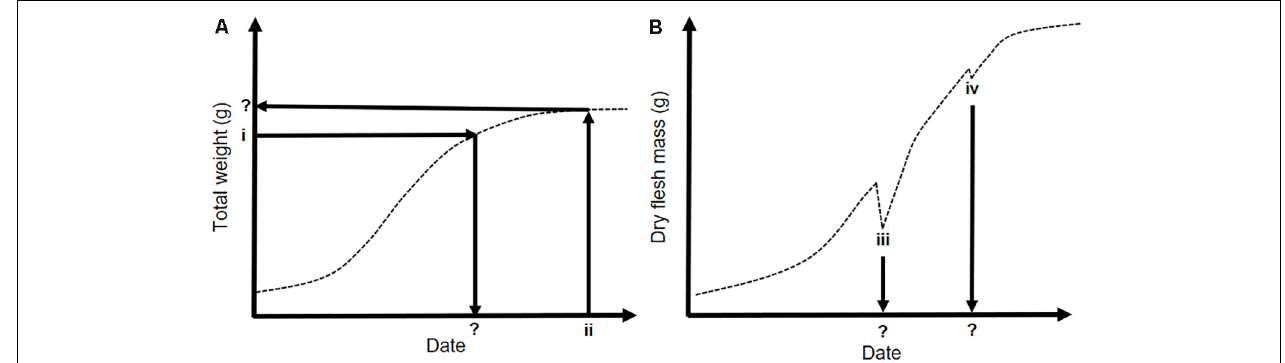
FIGURE 3 | Conceptual schematics of the types of growth performance indicators developed in consultation with oyster growers and professionals and extracted from our modeled growth time series maps. (A) Total oyster weight as a function of time throughout the growing season. (i) Represents the date a target weight is achieved as the parameter of interest, e.g., minimum market weight (30 g). (ii) Takes a given date of interest as the starting point (e.g., early December, in time for the main French oyster market), and looks at what total weight is achieved by this date. (B) Dry flesh mass (DFM) over time throughout the growing season; sharp decreases in DFM indicate spawning events. (iii) and (iv) Indicate the timing of these spawning events, and can also be summed to determine the number of spawning events at a given site in a given